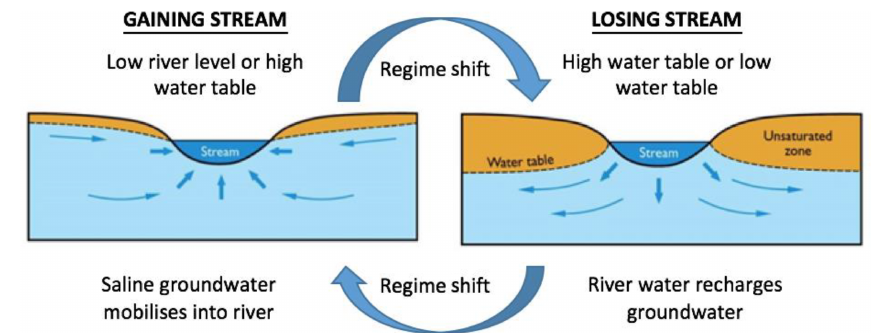
Figure 3. Processes affecting saline groundwater accessions for gaining and losing